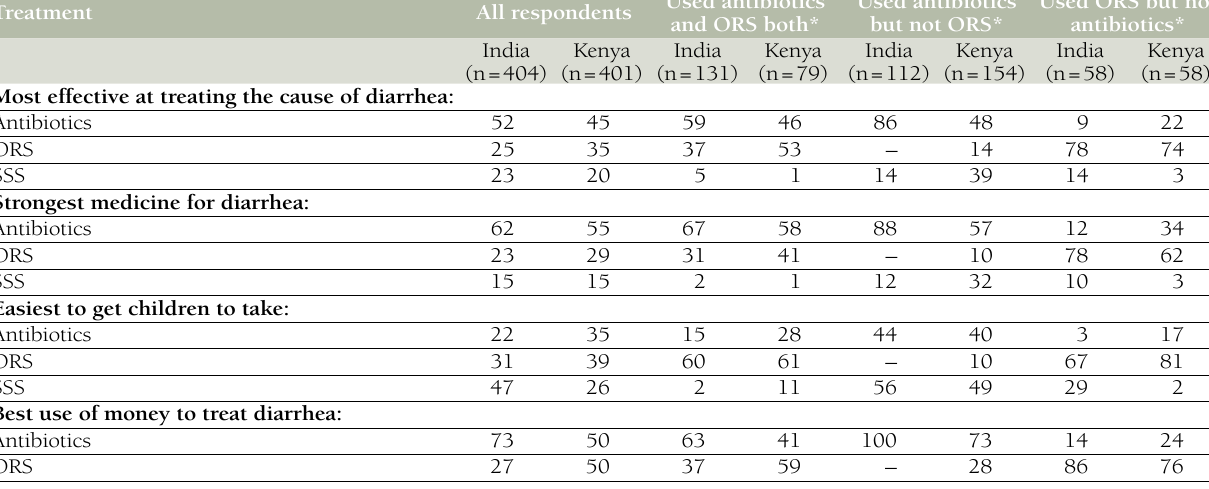
Table 3. Ranking of main treatments (% rating as the 1st choice)